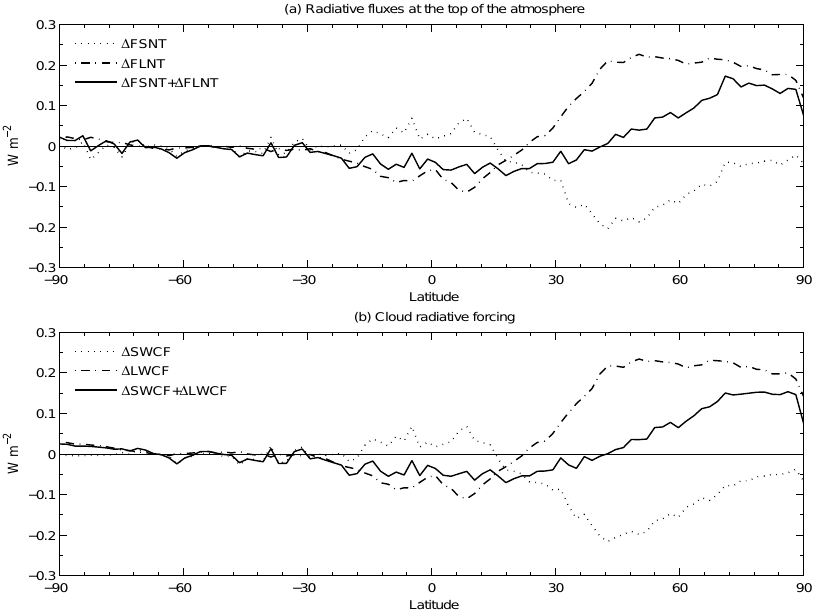
Figure 11. Zonal average of radiative fluxes at the top of the atmosphere energy balance (shortwave: FSNT; longwave: FLNT) and cloud radiative forcing (shortwave: SWCF; longwave: LWCF) in mWm − 2 due to aviation BC based on 2050BL emissions with 2050 RCP8.5